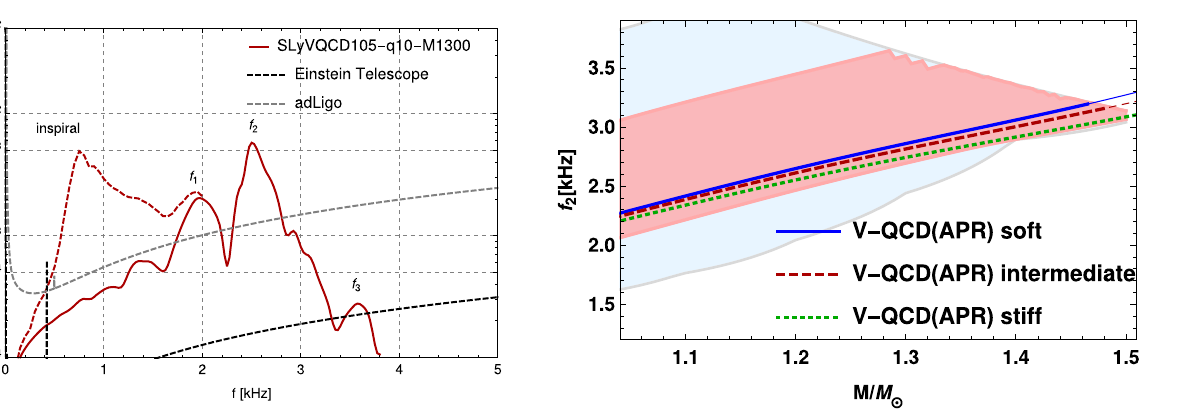
Fig. 24 The prediction for the peak frequency f 2 as a function of neu- tron star mass for equal mass mergers from the approximate relations derived in [367] using the hybrid EOSs as input. Notation as in Figs. 15 and 17: the light blue (red) band is spanned by all (hybrid holographic) EOSs satisfying the astrophysical bounds. The curves show the predic- tions for the three V-QCD(APR)